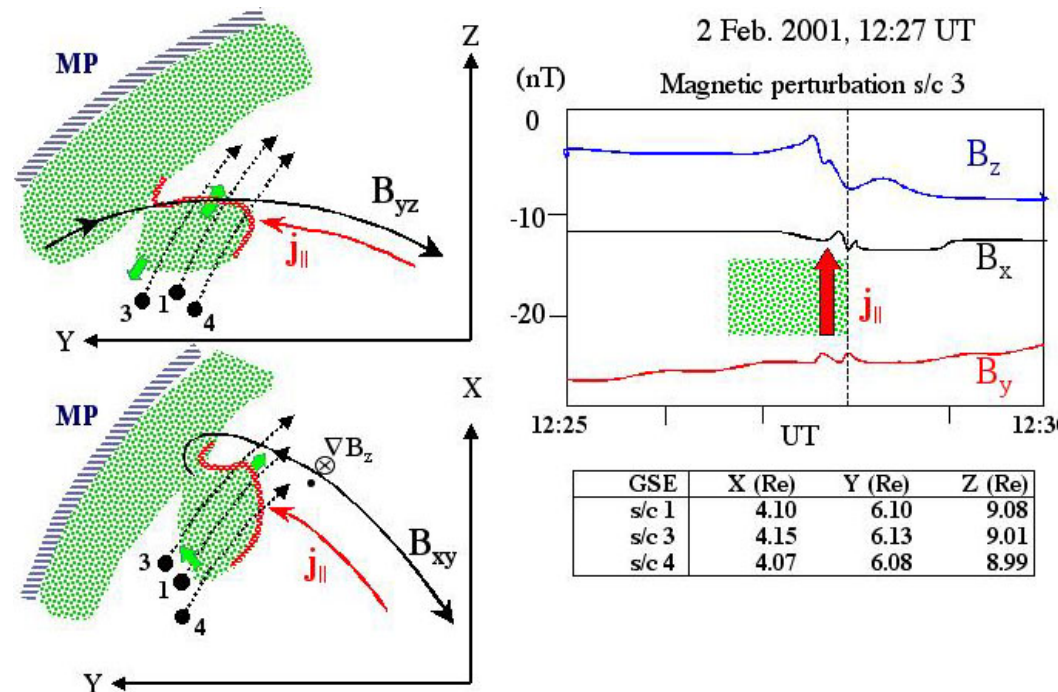
Fig. 10. Diagrammatic representation of the “stagnant” PTE on 2 February 2001,